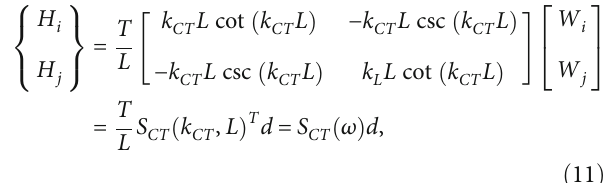
ffiffiffiffiffiffiffiffiffiffiffiffiffiffiffiffi ω 2 ρ A / T